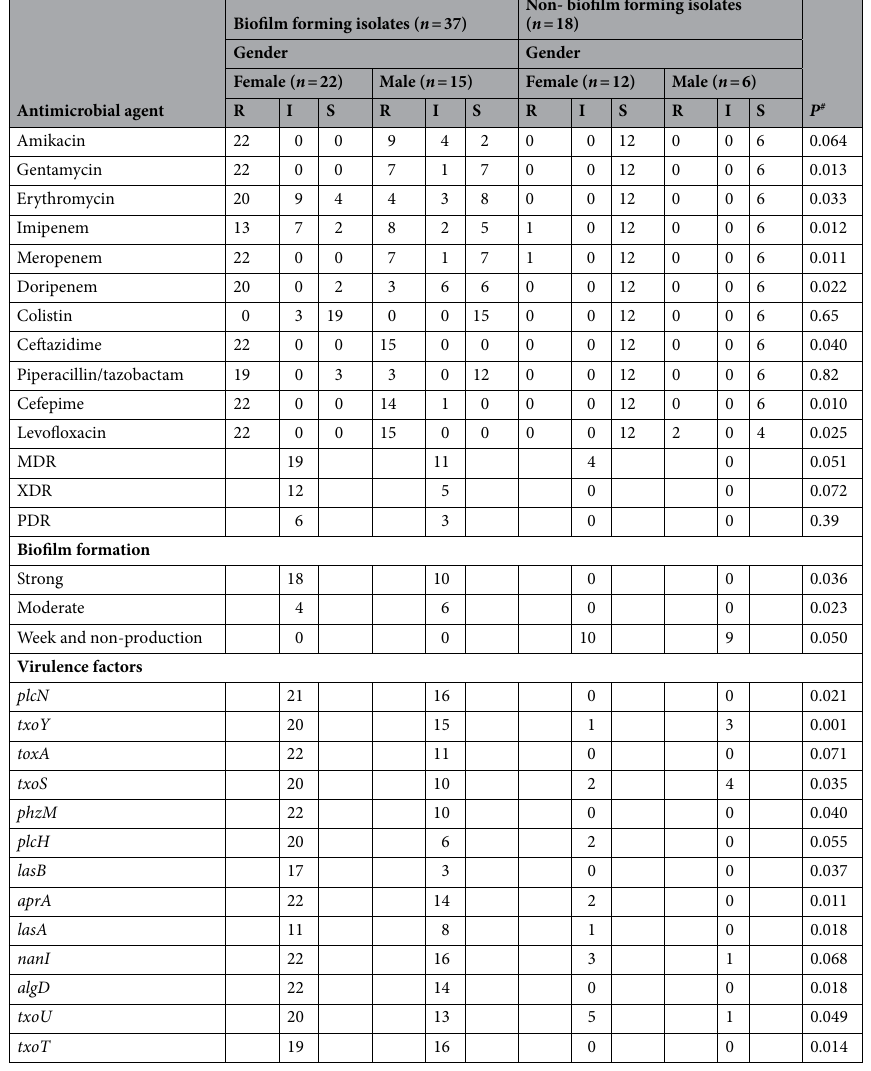
Table 1. Frequency of antibiotic resistance, and virulence factors in biofilm producing and non-biofilm producing P. aeruginosa wound